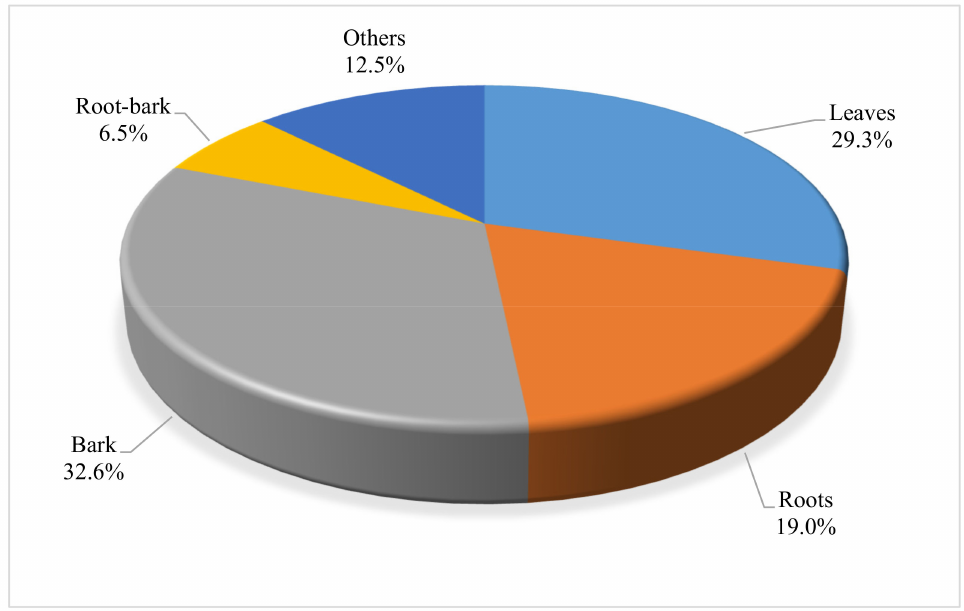
Figure 2. Distribution of different parts of woody plants used in the preparation of ethnoveterinary remedies in South Africa. Others denote parts such as seeds, fruits, flowers, and twigs. ( n = 184).